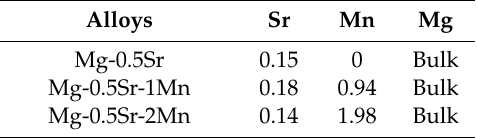
Table 1. The chemical compositions of Mg-0.5Sr-xMn alloys